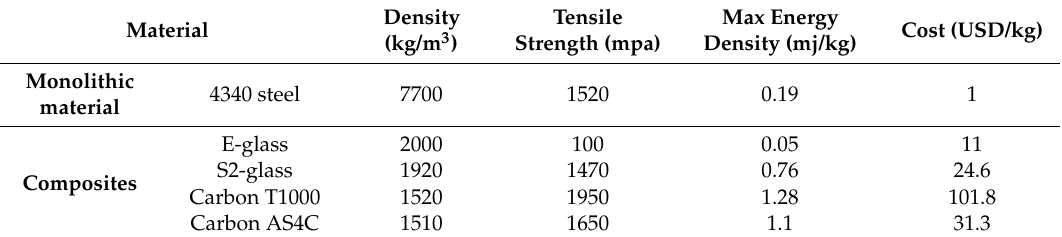
Table 14. Vehicles using different storage systems. Storage System